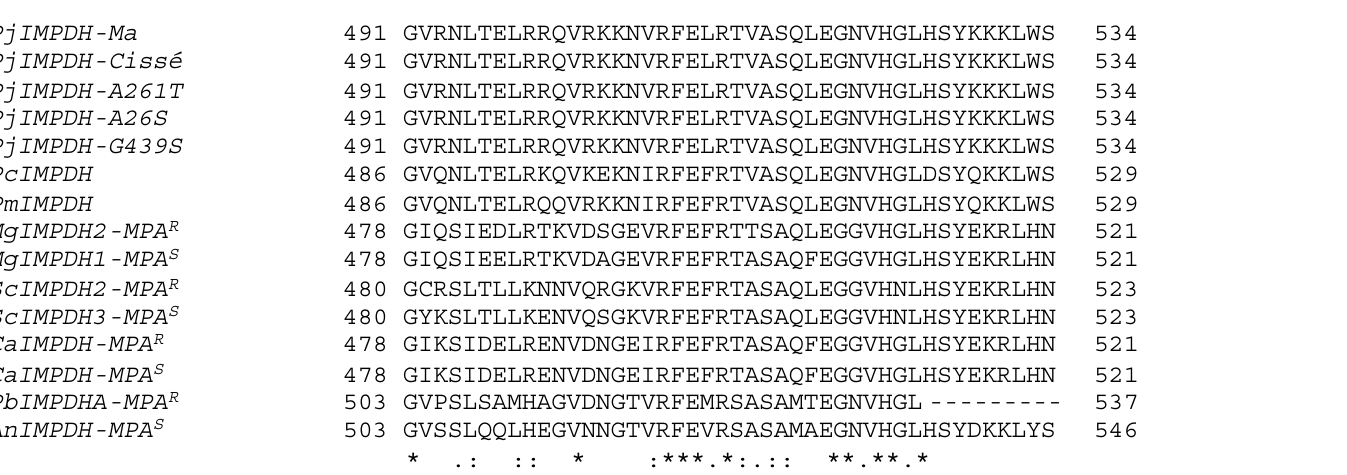
Figure 1. Sequence alignment of IMPDH proteins of Pneumocystis jirovecii, Pneumocystis carinii, Pneumocystis murina, Meyerozyma guilliermondii, Saccharomyces cerevisiae, Candida albicans, Penicillium brevicompactum and Aspergillus nidulans . Identical, strongly and weakly conserved residues are indicated by asterisks, double points and single points, respectively. Dashes indicate gaps. Polymorphic residues of P. jirovecii IMPDH and the analogous residues in other fungi are indicated in bold. PjIMPDH-A261T : IMPDH sequence of P. jirovecii with a missense mutation Ala261Thr identified in the present study; PjIMPDH-A26S : IMPDH sequence of P. jirovecii with a